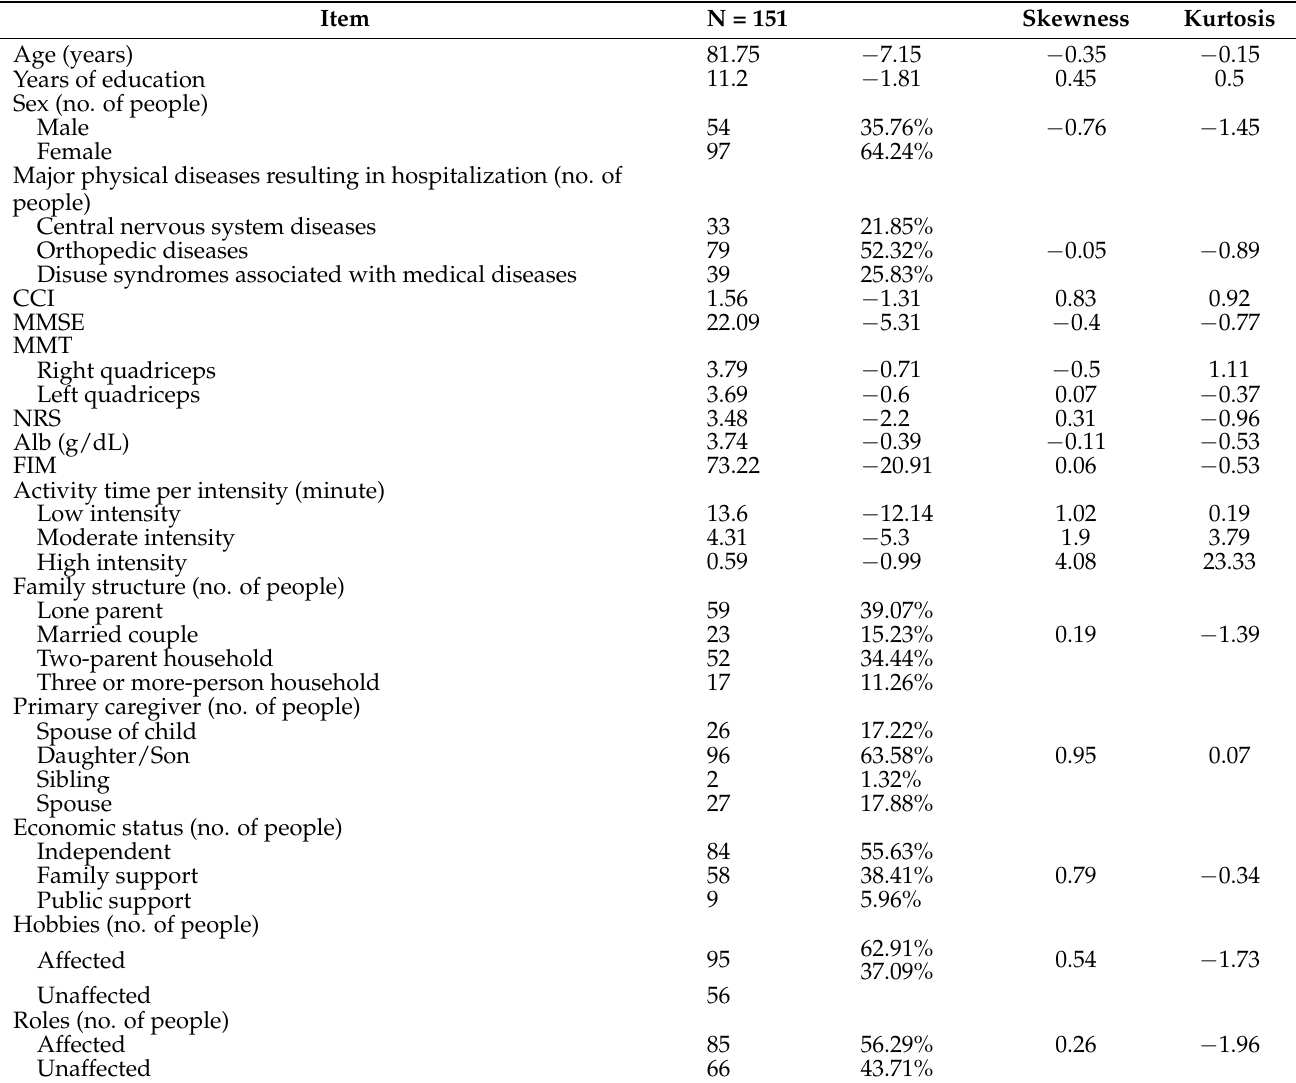
Table 1. Characteristics of participants and scores for each assessment. (N =